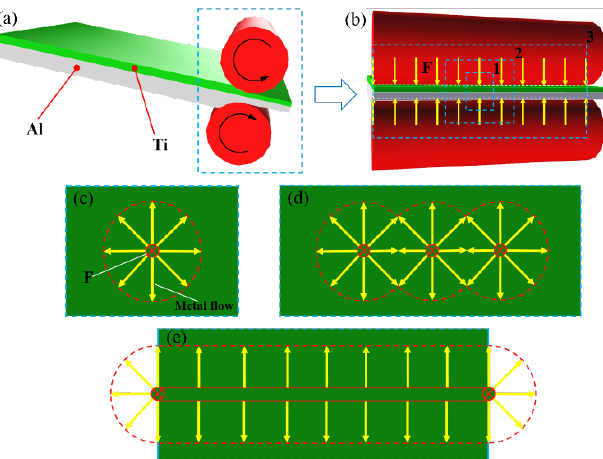
Figure 11. Metal flow schematic diagram of the Ti/Al laminated composites during rolling process. ( a ) rolling process, ( b ) stress distribution on the surface of the metal sheets, ( c ) metal flow at frame line 1 (single-point compression) in Figure 11b, ( d ) metal flow at frame line 2 (three-point compression) in Figure 11b, ( e ) metal flow at frame line 3 (line compression) in Figure 11b.